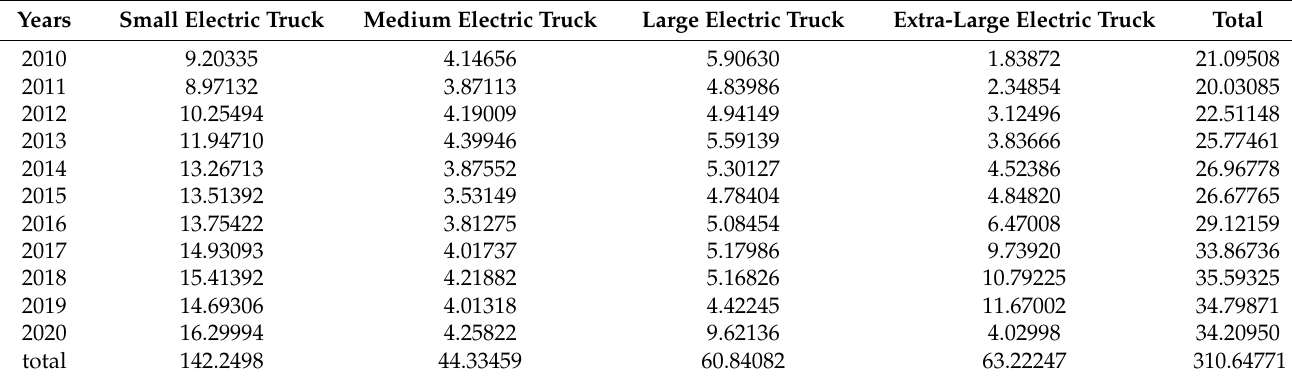
Table 6. Guixin expressway 2010–2020 truck flow meter (unit: 100,000